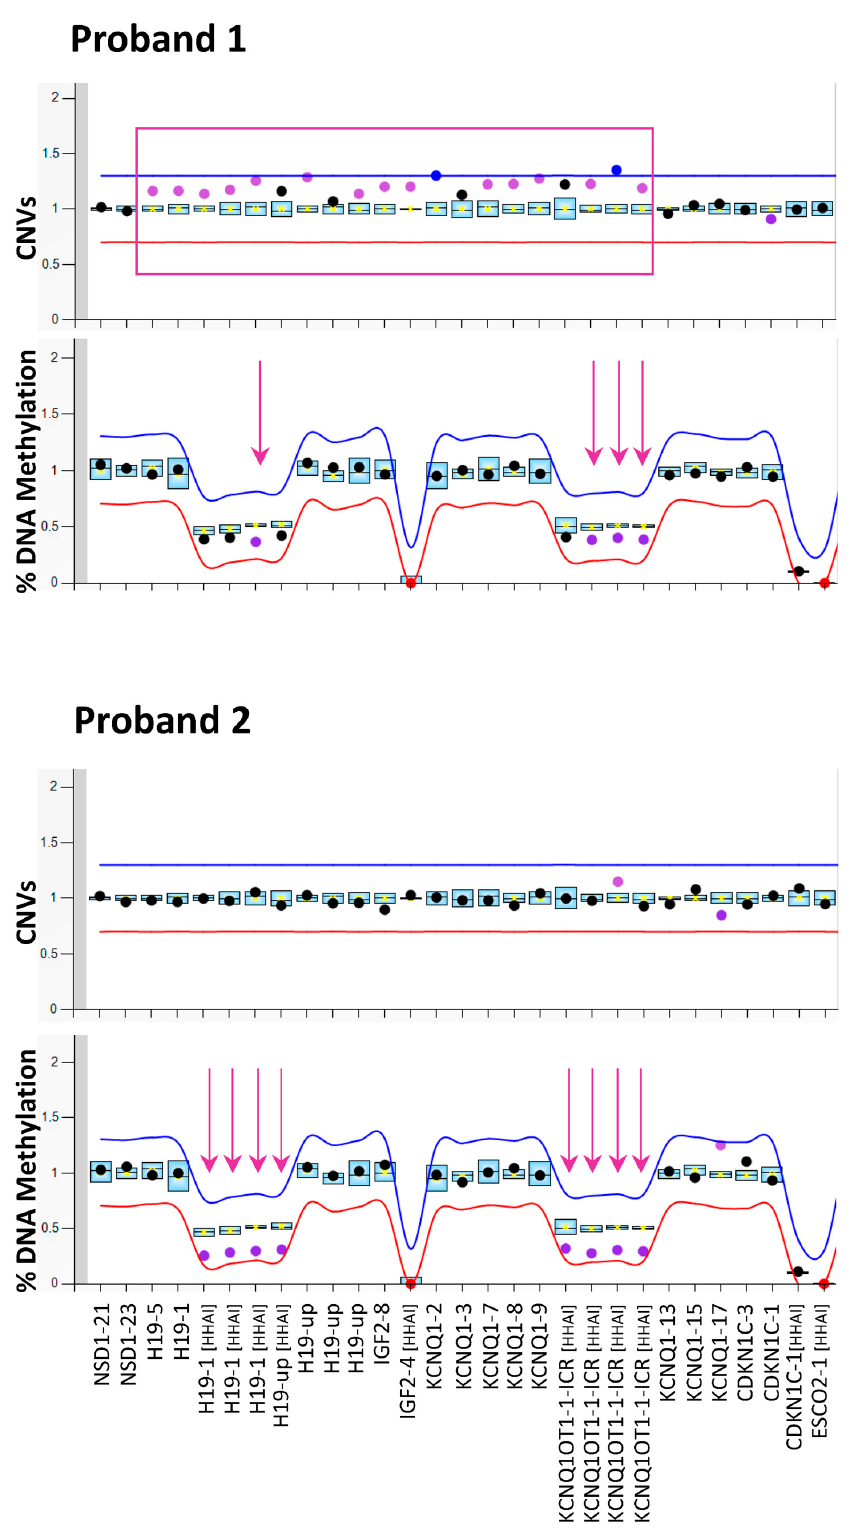
Figure 1. Molecular testing of SRS by MS-MLPA. Copy number (CNVs, upper panels) and DNA methylation (lower panels) of the 11p15 imprinting genes cluster analysed on PBL DNA of both the probands by ME030 BWS/SRS diagnostic kit. The mean values of three control subjects were used for assessment of relative copy number and methylation percentage. Arrows indicate the probes detecting the methylation defect; rectangles indicate the probes detecting the